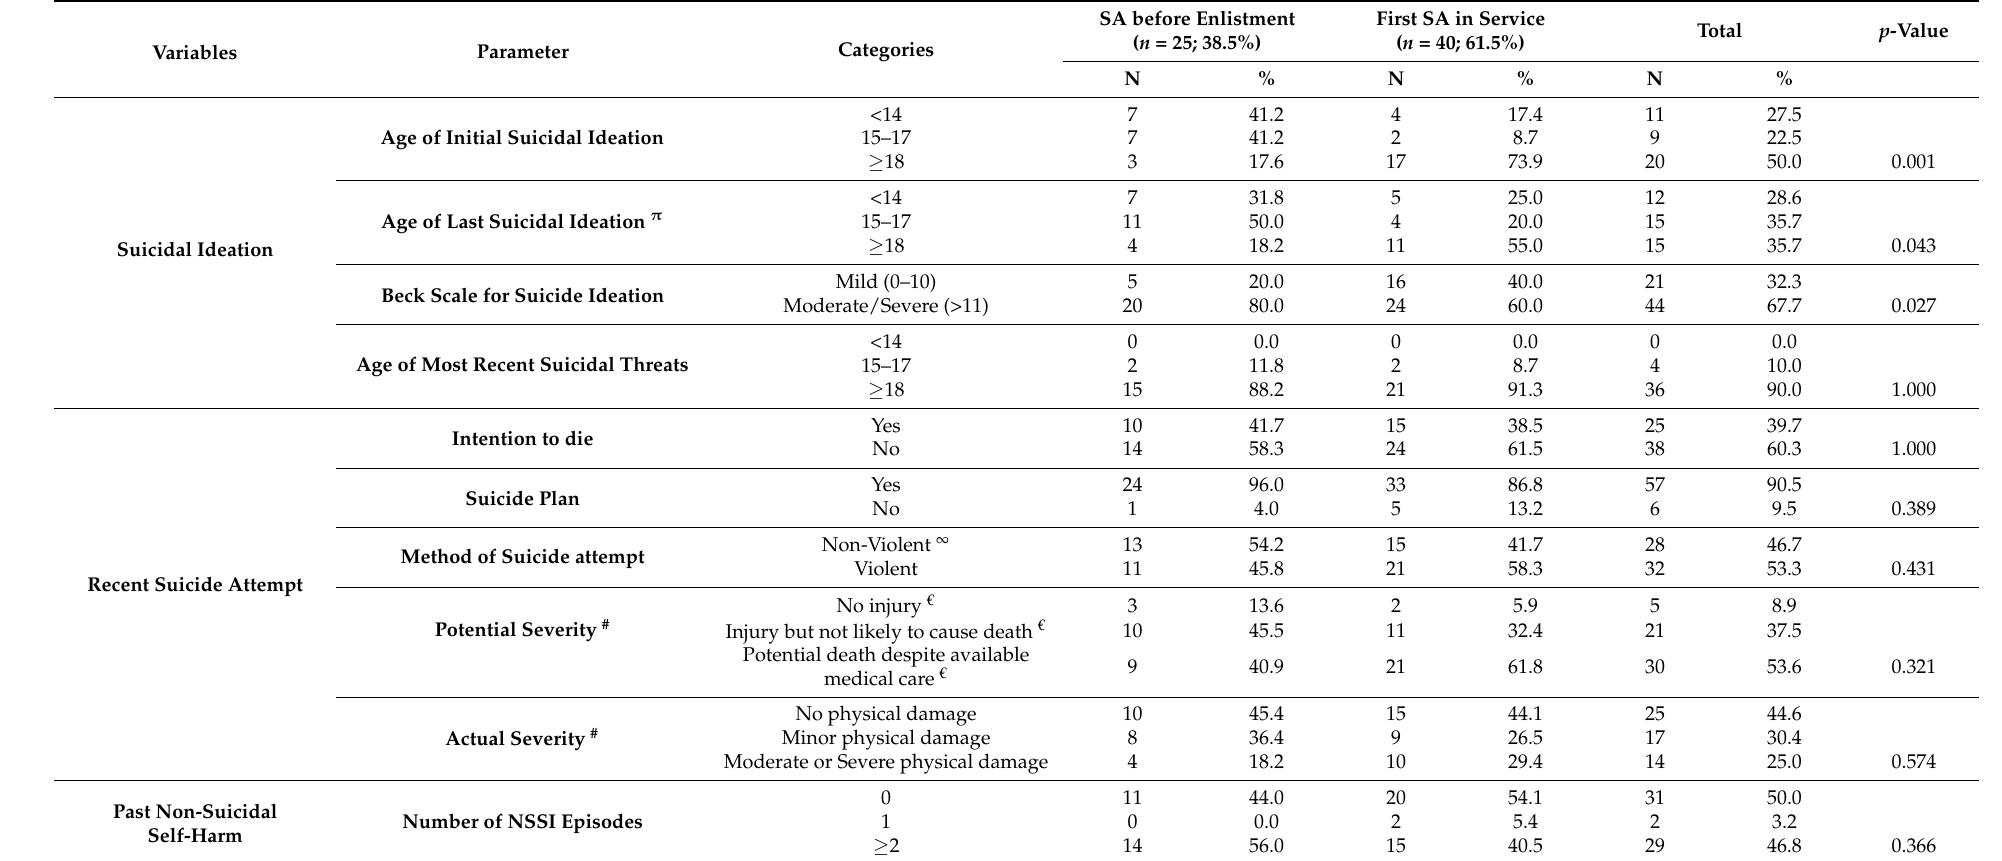
Table 2. Comparison of characteristics of suicidal thoughts and